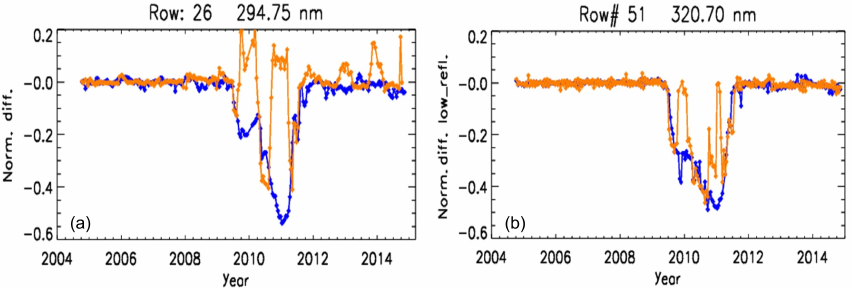
Figure 23. (a) Shows the wavelength-binned, normalized and de-trended UV1 radiances for the row 26 (counting from 1) for the 30 ◦ latitudinal bins centered on latitude − 45 ◦ (blue) and latitude 45 ◦ (orange). (b) Shows the same for the UV2 low-reflectivity ( r <15%) sub-sample of radiances registered by the row 51 (in correspondence to the FOV of the UV1 row 26) . The plotting ranges correspond to − 60% / + 20% changes of radiances.